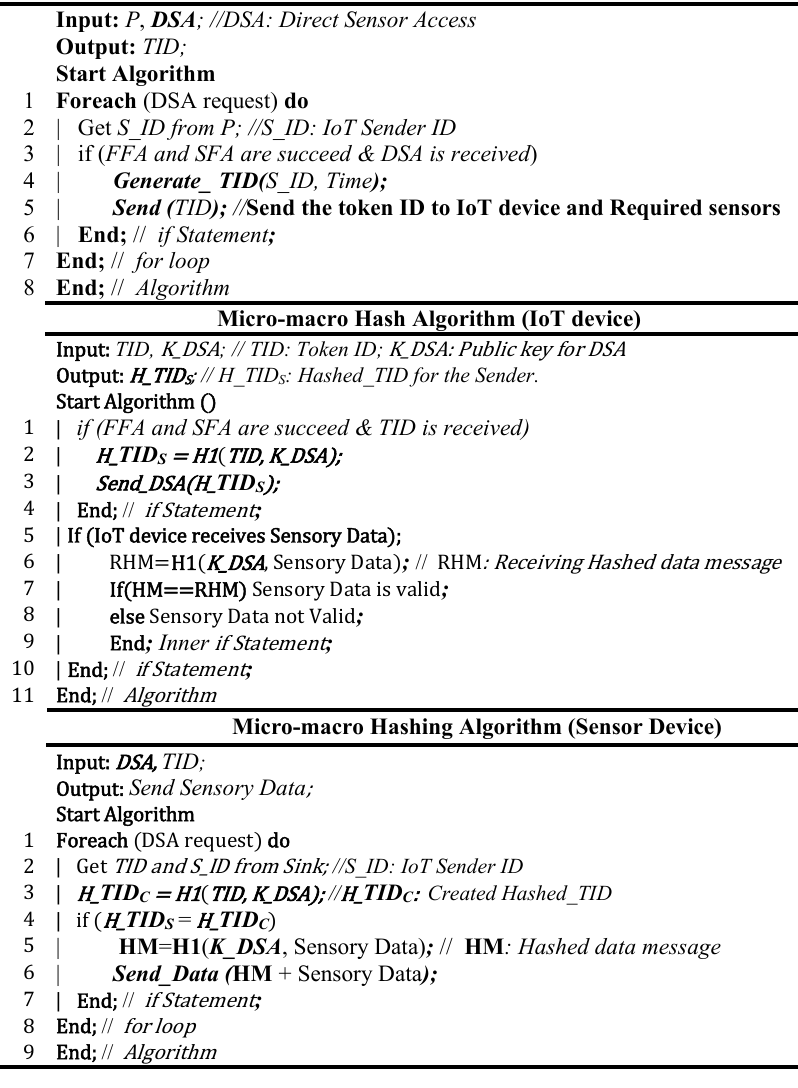
( a ) Micro–macro IoT authentication algorithm